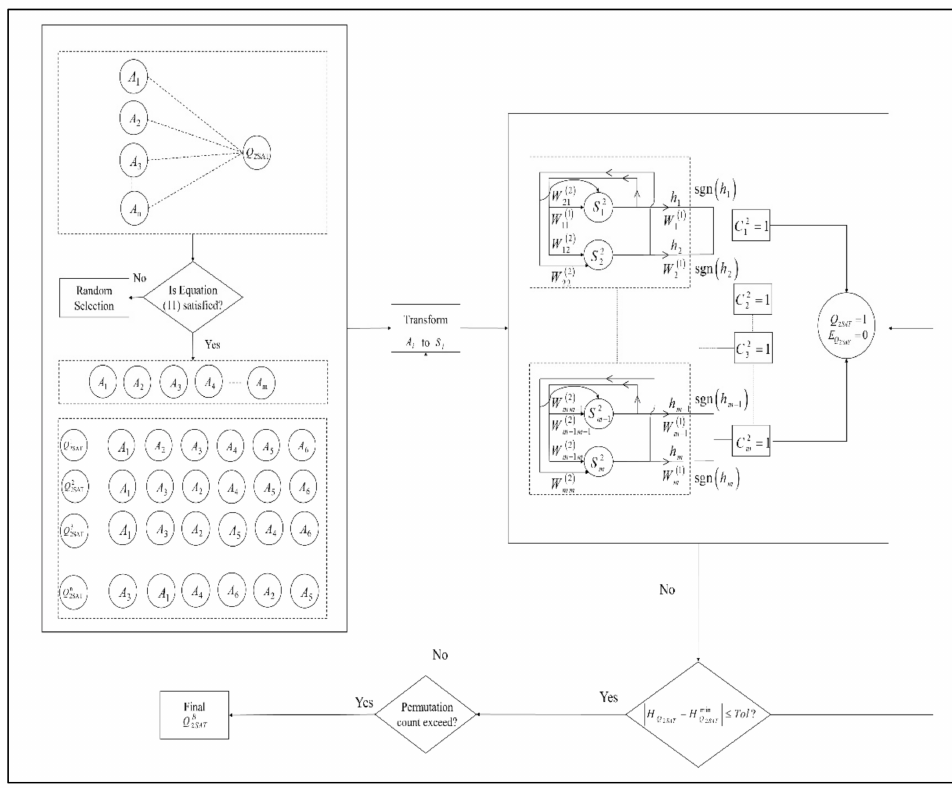
Figure 1. The implementation of the proposed S2SATRA.